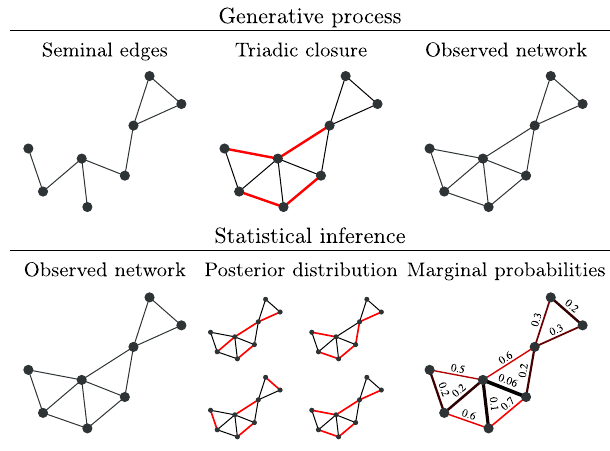
FIG. 1. Schematic representation of the generative process considered (top) and the associated inference procedure (bottom). The generative process consists in the placement of seminal edges according to a SBM and the addition of triadic closure edges conditioned on the seminal edges (shown in red). The inference procedure runs in the reverse direction, and given an observed graph, it produces a posterior distribution of possible divisions of seminal and triadic closure edges, with which edge marginal probabilities on the edge identities can be